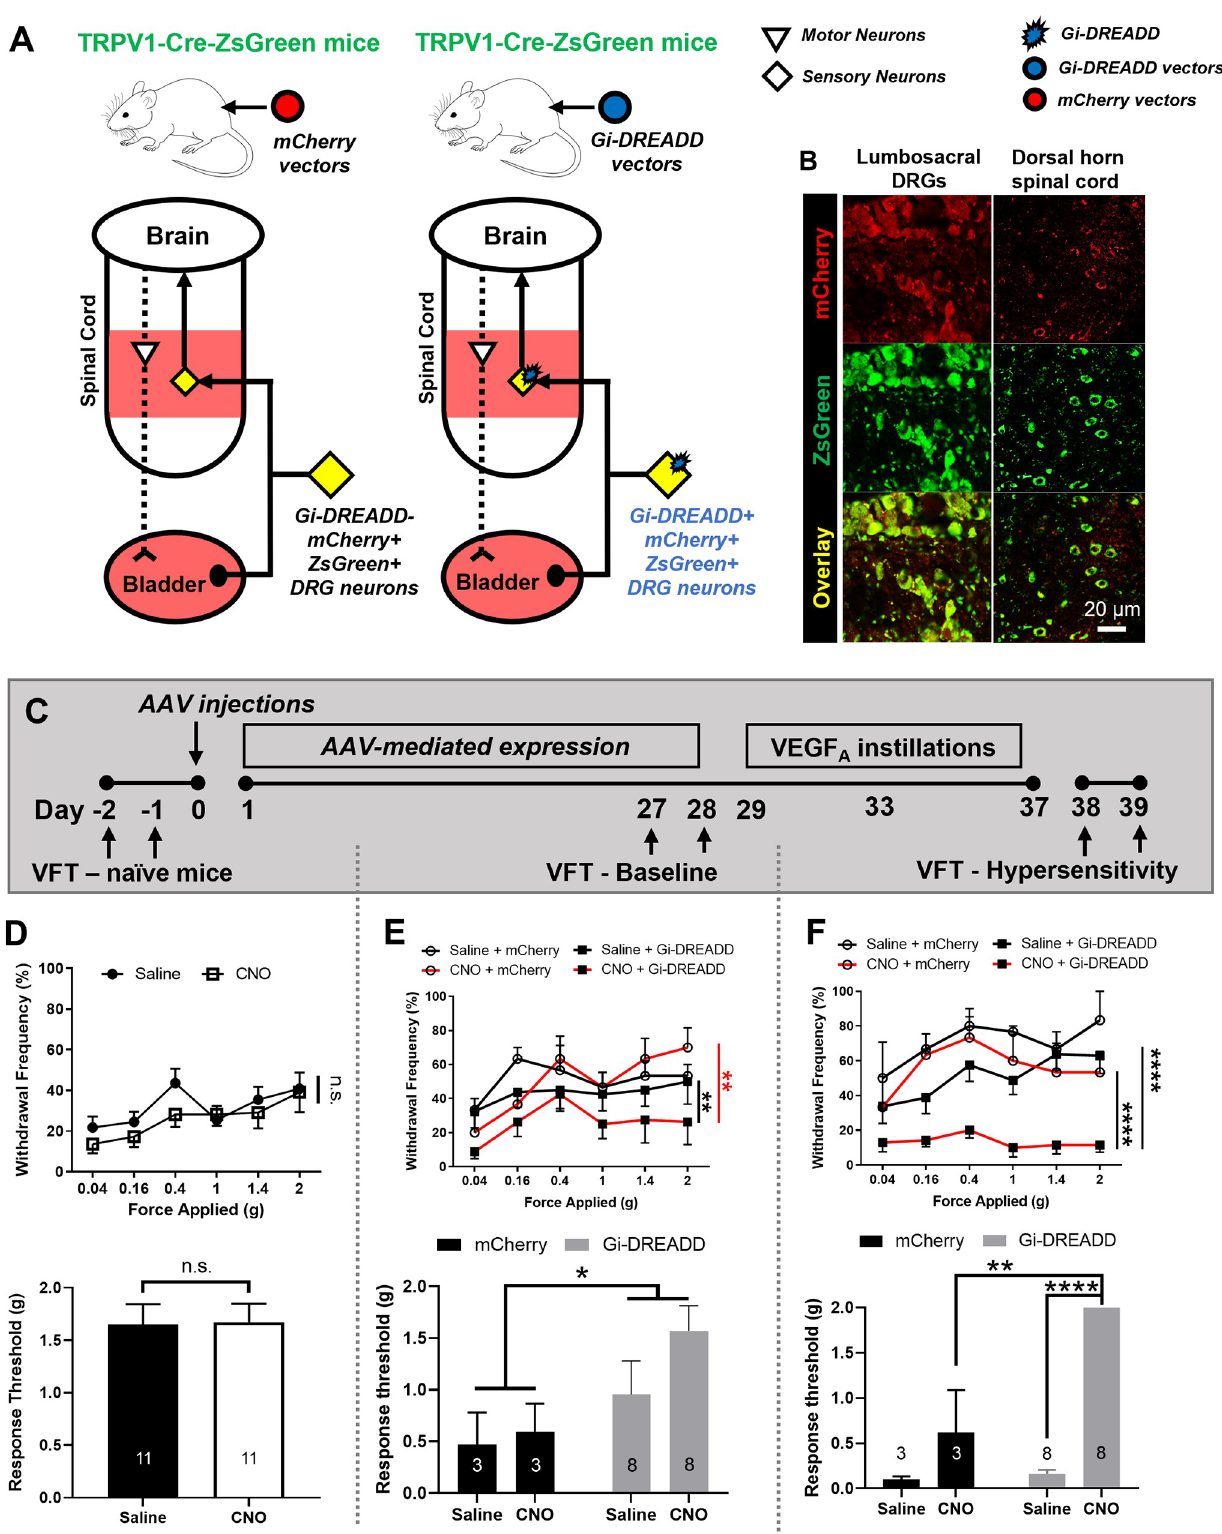
Fig 6. Pharmacogenetic inhibition of lumbosacral DRG neurons via AAV-mediated Gi-DREADD expression led to visceral mechanical analgesia. (A). AAV vectors containing Gi-DREADD or mCherry reporter were injected into TRPV1-Cre-ZsGreen mice to express Gi-DREADD in lumbosacral